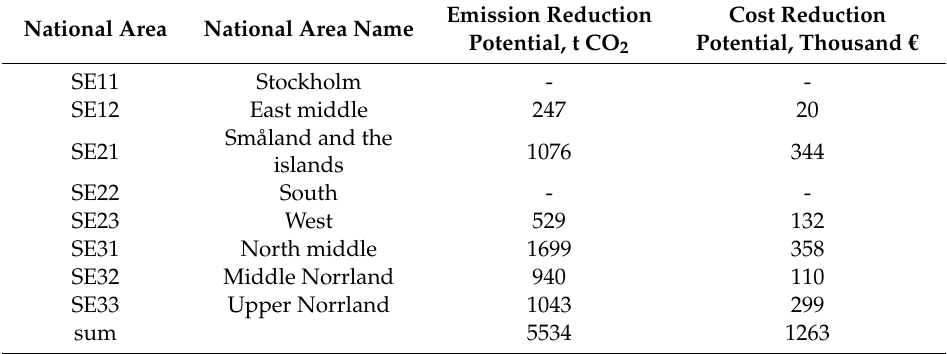
Table 4. Potential reductions in CO 2 emissions and fuel costs (after superimposed terminal costs) for the terminal supportive via-corridor transports.